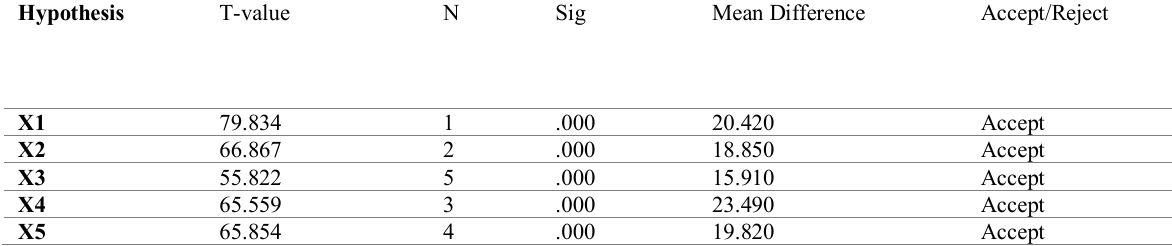
Table 11: One-Sample Test for